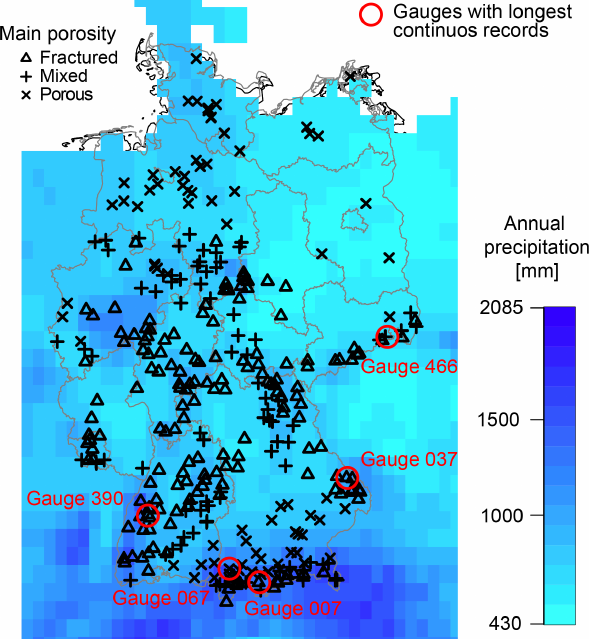
Figure 2. Location of gauges in Germany, catchments’ dominant type of porosity (derived from the German hydrogeological map) and mean annual precipitation sums (calculated from European Cli- mate Assessment and Dataset